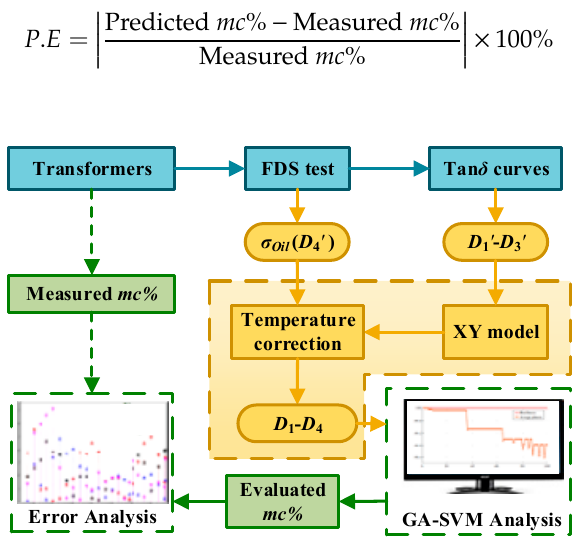
Figure 8. Tan δ curves of the lab samples. Table 8. Prediction results of the lab samples.